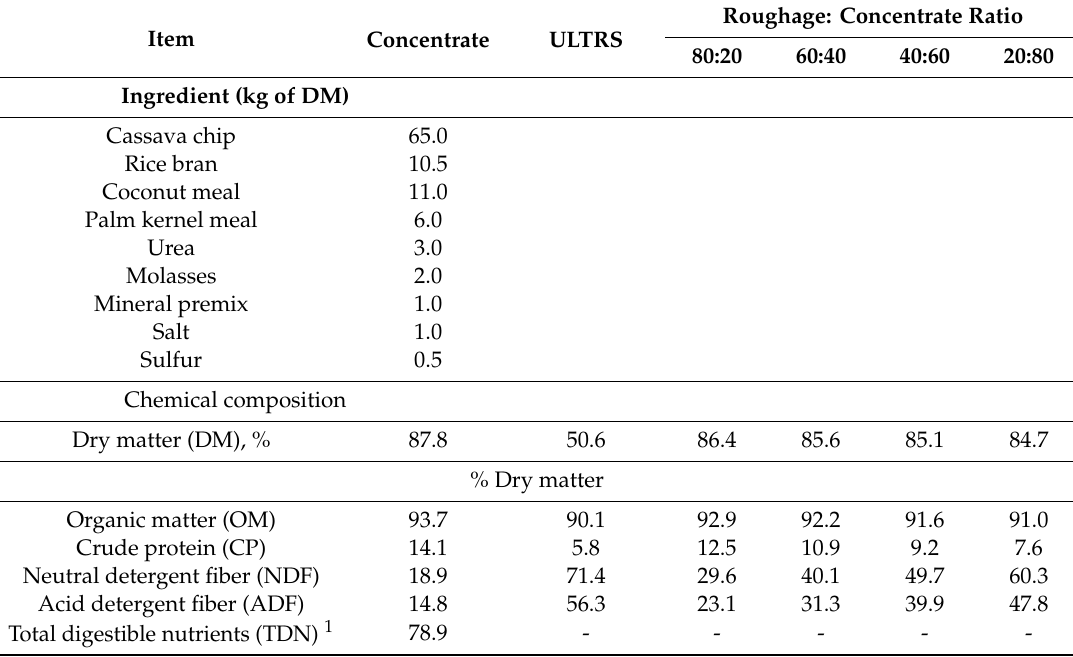
Table 1. Ingredients and chemical composition of concentrate and 2% urea plus 2% calcium hydroxide (Ca(OH) 2 ) treated rice straw (ULTRS) used in the